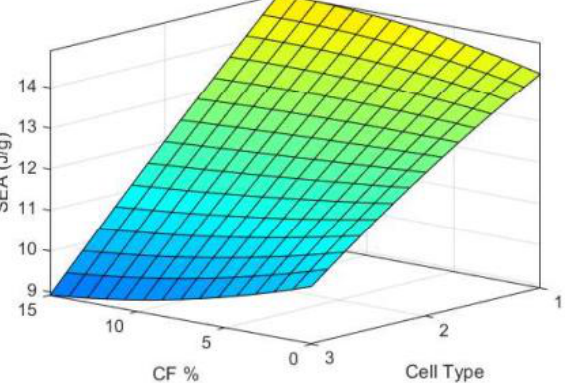
Figure 19. ANFIS 3D surface plot of SEA variation with the CF and cell type interaction at a cell size of 12 mm and RD of 44%; 1, 2, and 3 denote Diamond, Gyroid, and Primitive, respectively.